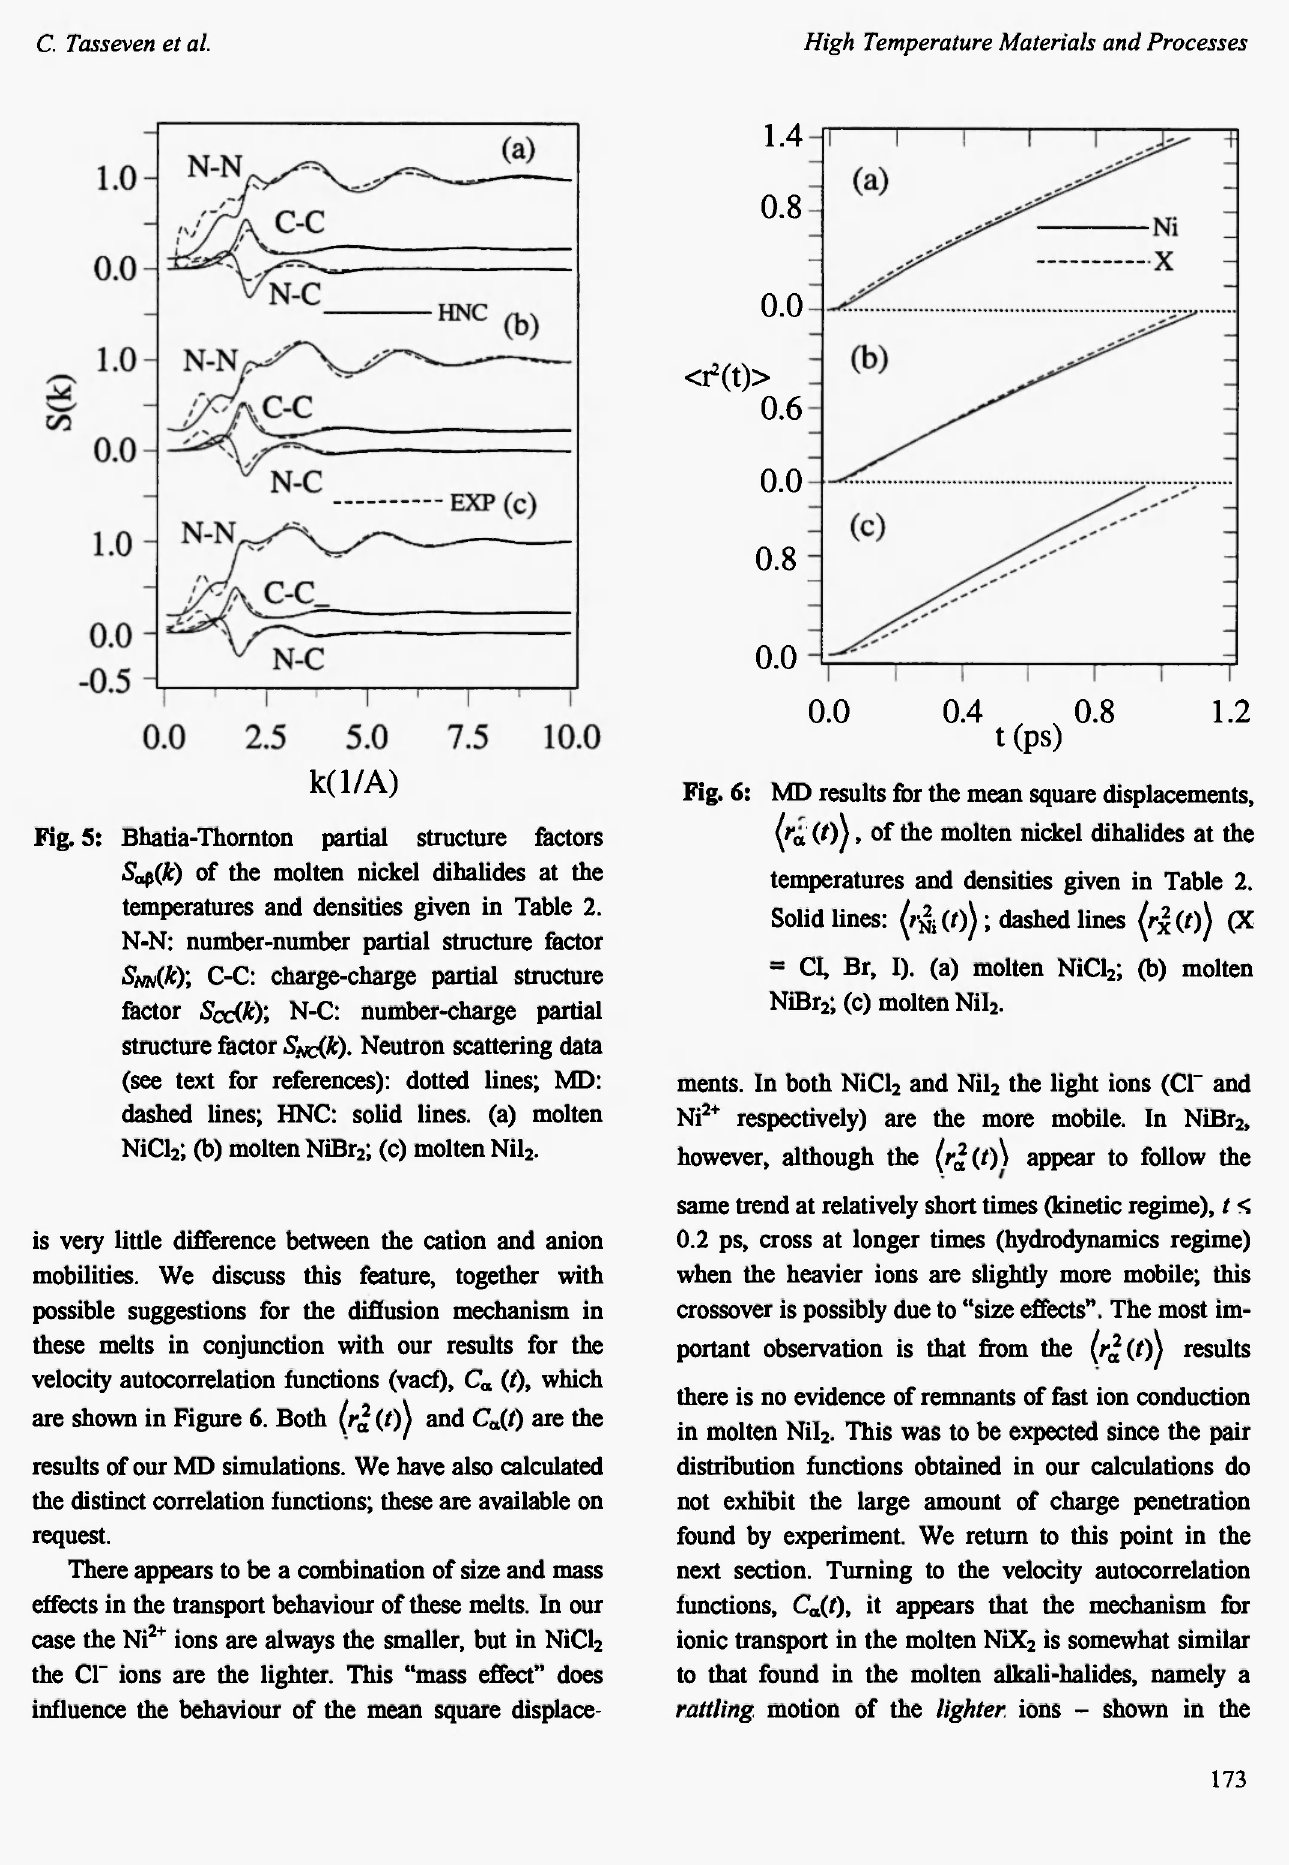
Fig. 6: MD results for the mean square displacements, ( r a (θ), of the molten nickel dihalides at the temperatures and densities given in Table 2. Solid lines: (i&(Q); dashed lines (/£(/)) (X = CI, Br, I), (a) molten NiCl ; (b) molten 2 NiBr ; (c) molten Nil 2 2